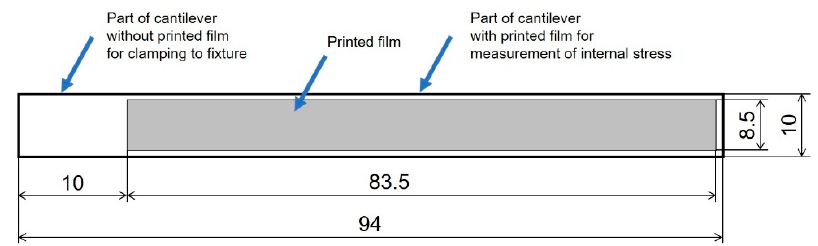
Figure 2. Dimensions of the substrate (cantilever) and the printed